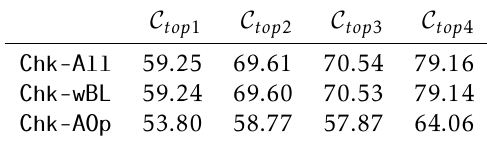
Table 3. Average ball size for all RockYou passwords over di˙erentcheckerpoliciesand